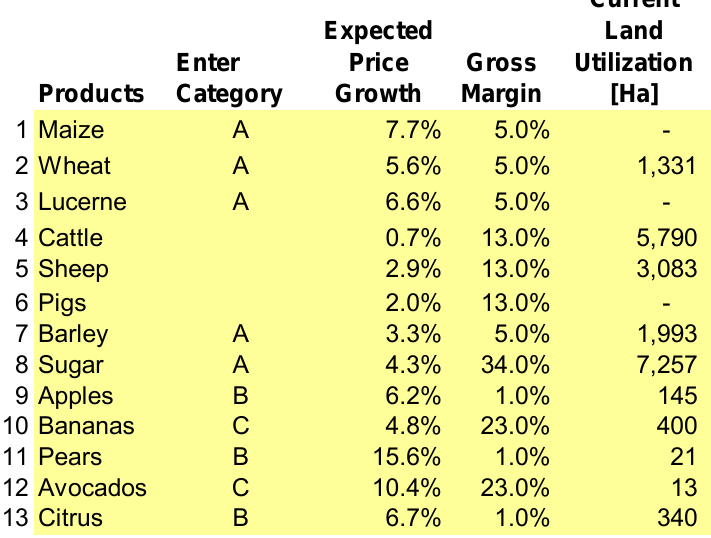
Figure 2 - Data template: expected price growth, gross margins and current land utilisation for agricultural products